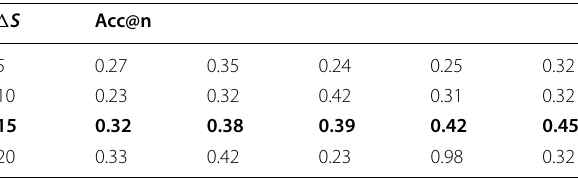
Table 6 Impact of time period/seasons (cid:31) S over accuracy for top@n